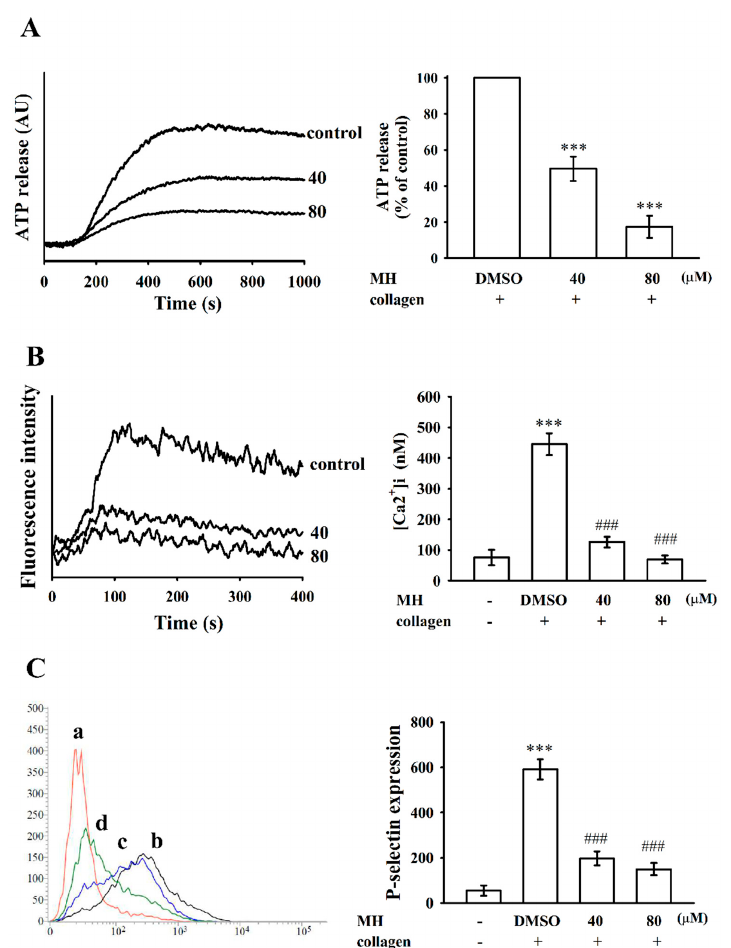
Figure 2. Effects of morin hydrate on adenosine triphosphate (ATP) release, relative intracellular Ca 2+